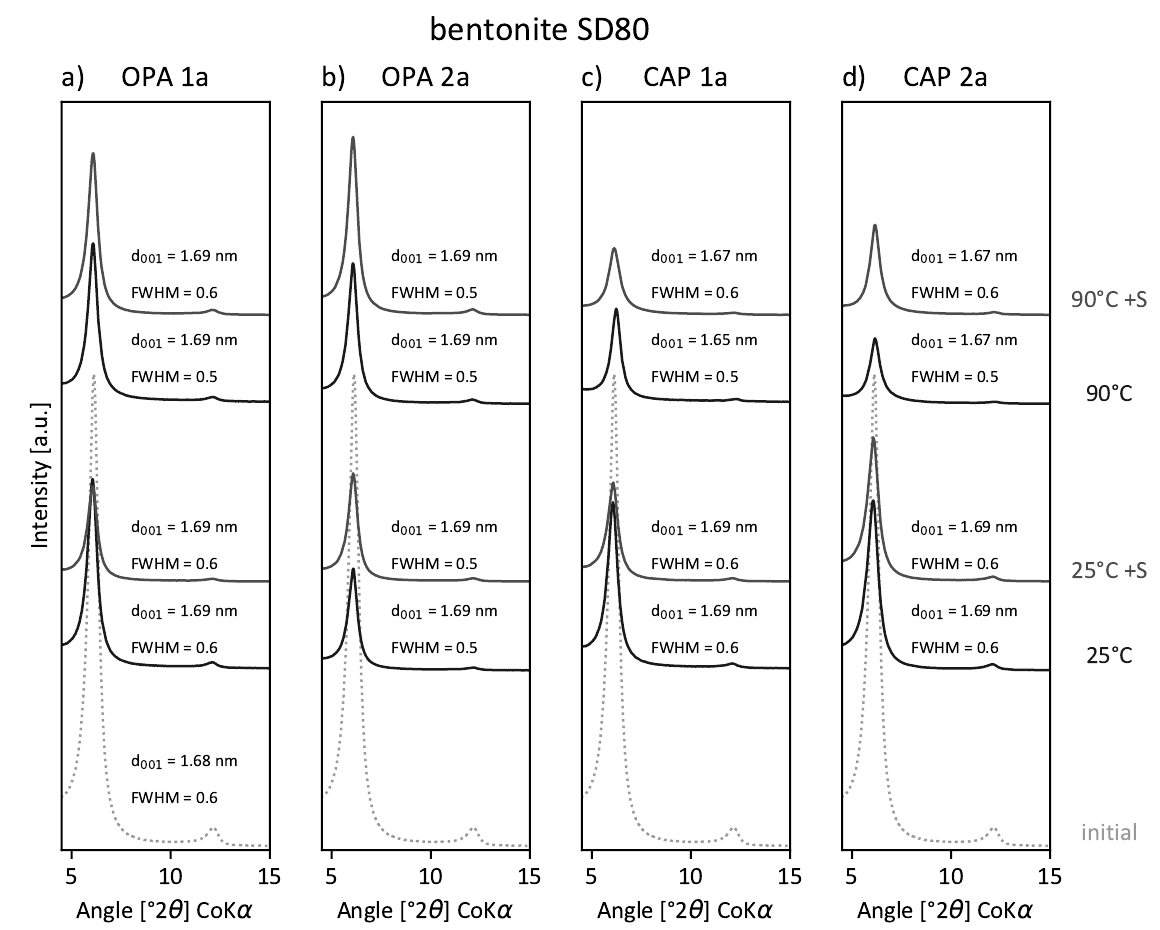
Figure 5. XRD patterns (oriented slides of purified smectite; ethylene glycol-saturated) of the initial SD80 bentonite and reacted samples at two different temperatures (25 and 90 ◦ C) with substrate (+S) and controls. ( a , b ) OPA solution for 1 and 2 years and ( c , d ) CAP solution for 1 and 2 years. Besides for an overall decrease of reflection intensity, no changes in d-spacing and full-width-at-half-maximum (FWHM) were observed. FWHM in ∆ ◦ 2 θ . OPA: Opalinus clay pore water, CAP: diluted cap rock